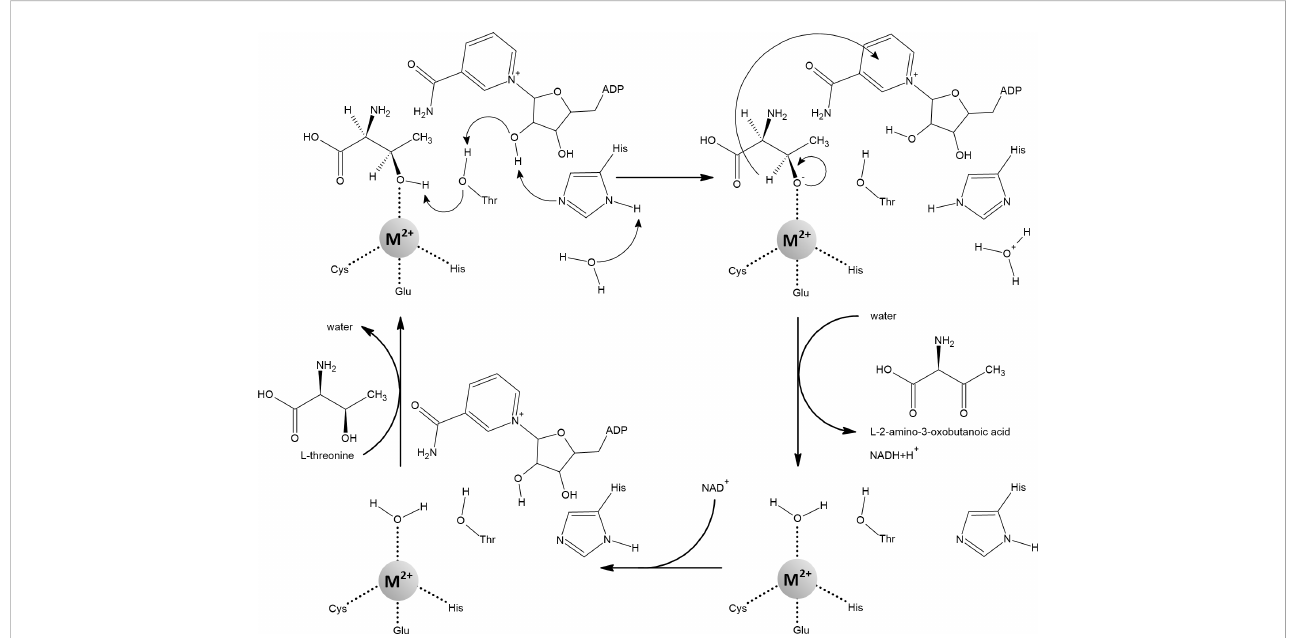
FIGURE 14 Catalytic mechanism of medium-chain L -threonine dehydrogenase. Only after the binding of NAD+ can L -threonine be accommodated in the active site. During this process, a water molecule is displaced from the coordination shell of the catalytic metal ion. The 3-hydroxyl group of L -threonine is activated by coordination with the metal ion, resulting in the loss of a proton that is released to the external solution. The resulting oxyanion, stabilized by the metal ion, forms a double bond with the third carbon of the substrate and simultaneously transfers a hydride to NAD+. To date, zinc appears to be the most suitable and frequent metal in medium-chain L -threonine dehydrogenases, but there is growing evidence that other metals can also serve this function. When iron is bound, the enzyme becomes sensitive to oxidative stress (Epperly and Dekker, 1991; Machielsen and van der Oost, 2006; Higashi et al., 2008; Bashir et al., 2009; Plapp, 2010; Anjem and Imlay,